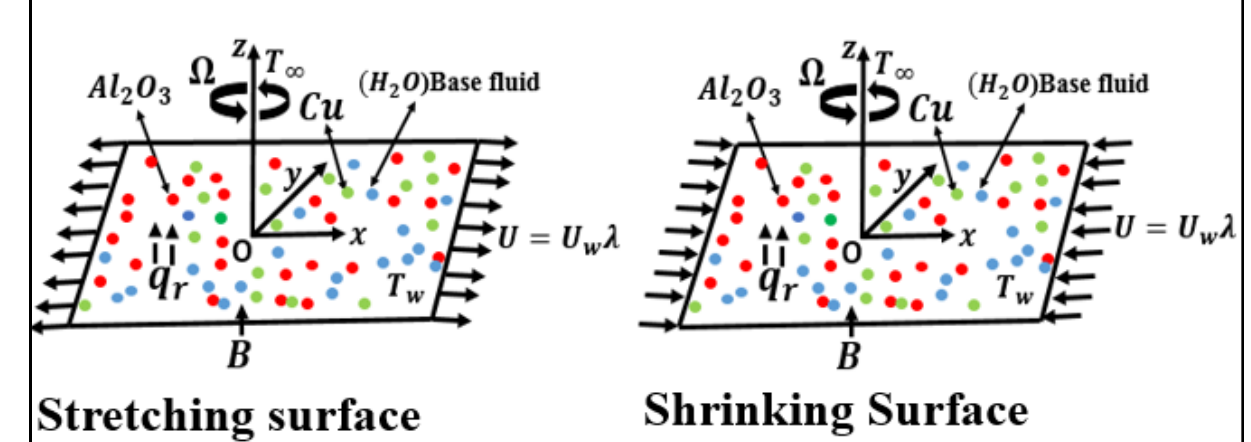
Figure 1. The physical model of a stretching/shrinking surface.